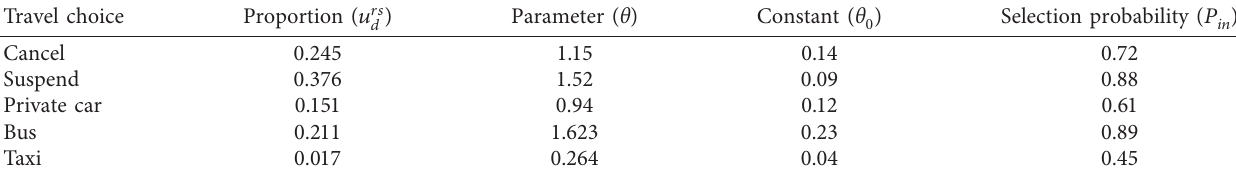
Table 7: Traveler type and nonaggregate parameter